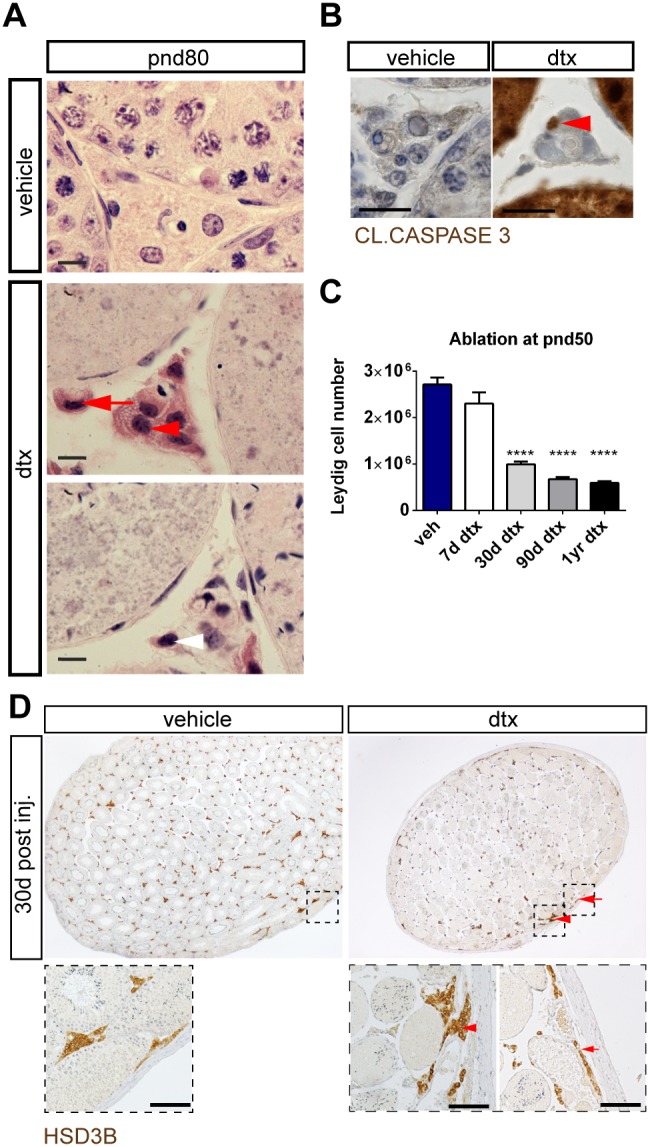
Sertoli cell ablation in adulthood induces apoptotic loss of Leydig cells.(A) Testicular histology on 2.5 µm resin sections (stained with hematoxylin and eosin) shows altered Leydig cell morphology 30 days after Sertoli cell ablation at pnd50. Leydig cells show increased vacuolization of the cytoplasm (red arrowhead), while some cells have an altered nuclear shape (red arrow) or reduced cytoplasmic volume after Sertoli cell ablation (white arrowhead). (B) Immunolocalisation for CLEAVED CASPASE3 shows Leydig cells undergo apoptosis (red arrowhead) (scale bar: 25 µm). (C) Total Leydig cell number per testis at key time-points following Sertoli cell ablation at pnd50 (one-way ANOVA n = 3–13, ****P<0.0001). (D) Leydig cells (HSD3B) are restricted to the rete (red arrowhead) and subcapsular region (red arrow) following Sertoli cell ablation at pnd50. (scale bar: 100 µm). d,days; yr,year; dtx, injected with toxin; veh: vehicle control.